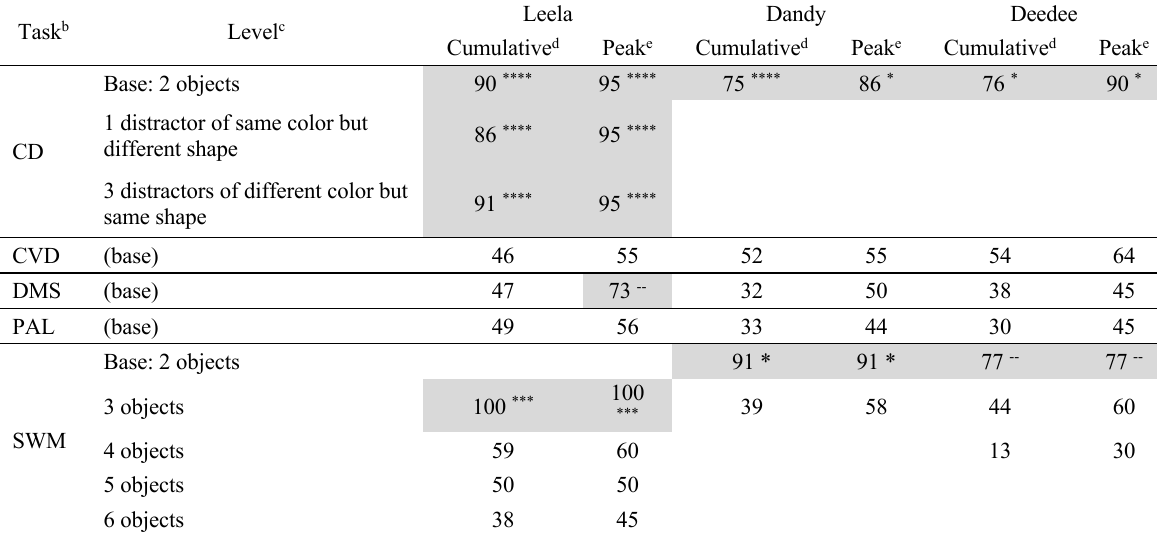
Note . Shaded results (values above 65% correct) were evaluated for statistical significance using the binomial test a . All